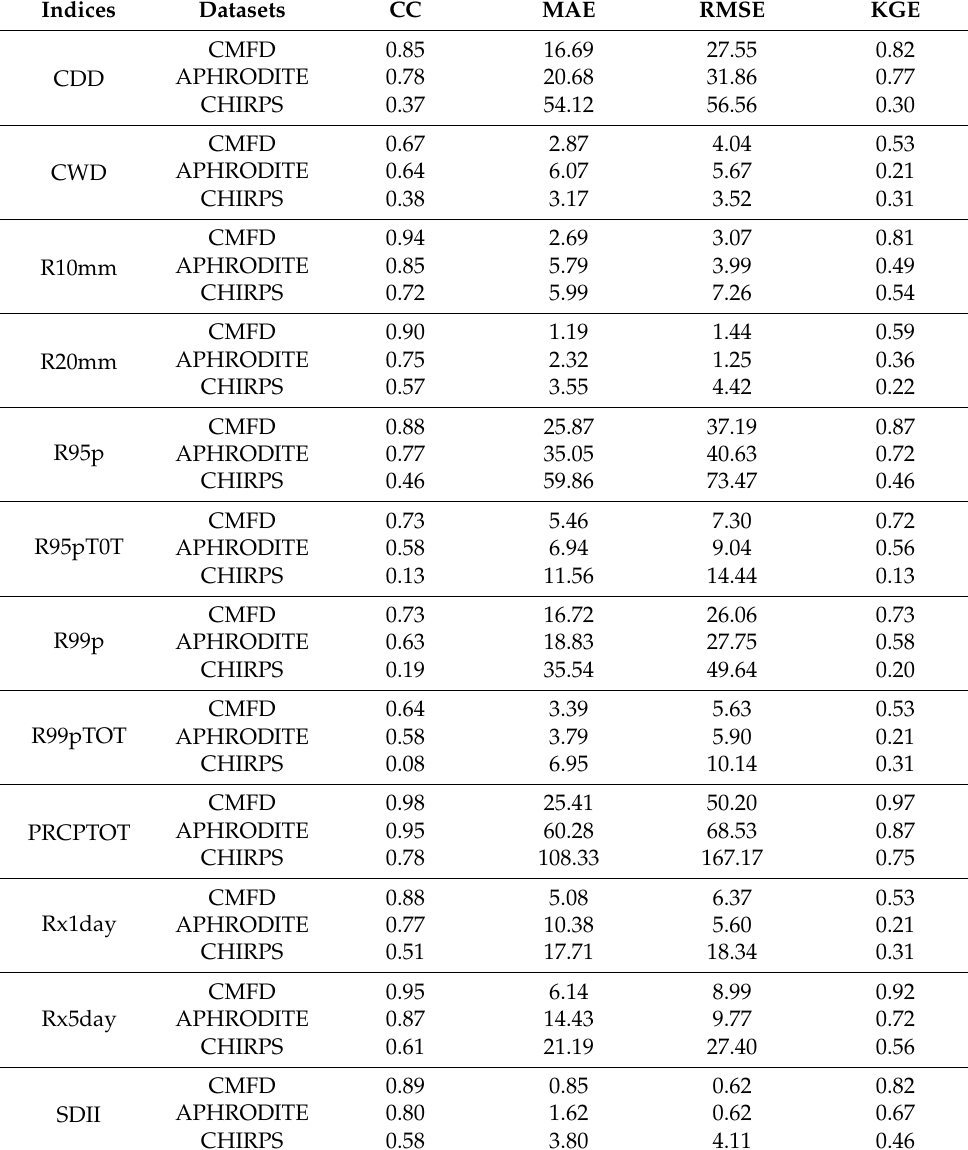
Table A2. Statistical metrics of annual extreme precipitation estimates derived from CMFD, APHRODITE, and CHIRPS for the period 1981–2014 with reference to gauge observations.